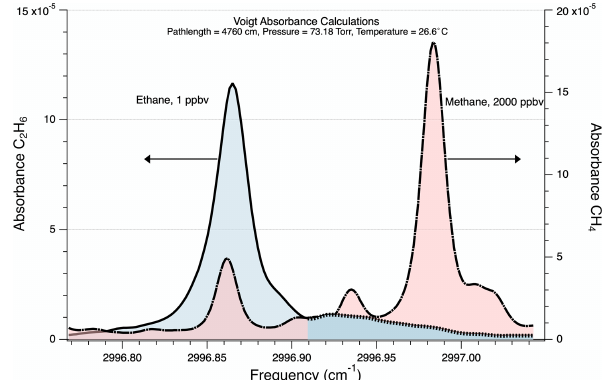
Figure 5. Ethane and methane simulated lines using Harrison et al. (2010) and HITRAN 2016 line parameters. Note the rather large wavelength spread of the ethane background data caused by a mul- titude of small ethane and methane lines in the wings. In the text we refer to this as a pedestal, and it is further highlighted by the blue area at the high-frequency side of the ethane absorption